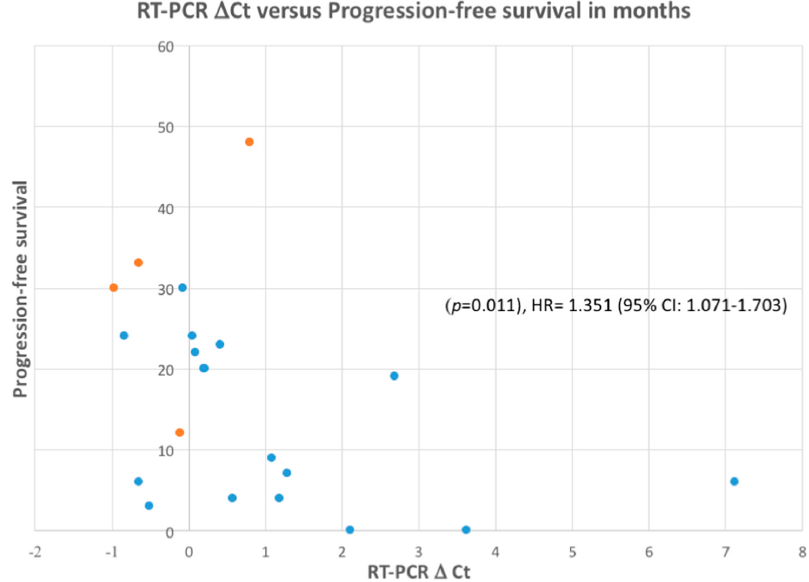
Figure 2. Association between RT-PCR Δ C t and progression-free survival (months) after starting the first-line ALK inhibitor crizotinib for ALK fusion-positive non-small cell lung cancer. Red dots represent cases that continue to respond to crizotinib at the time of data